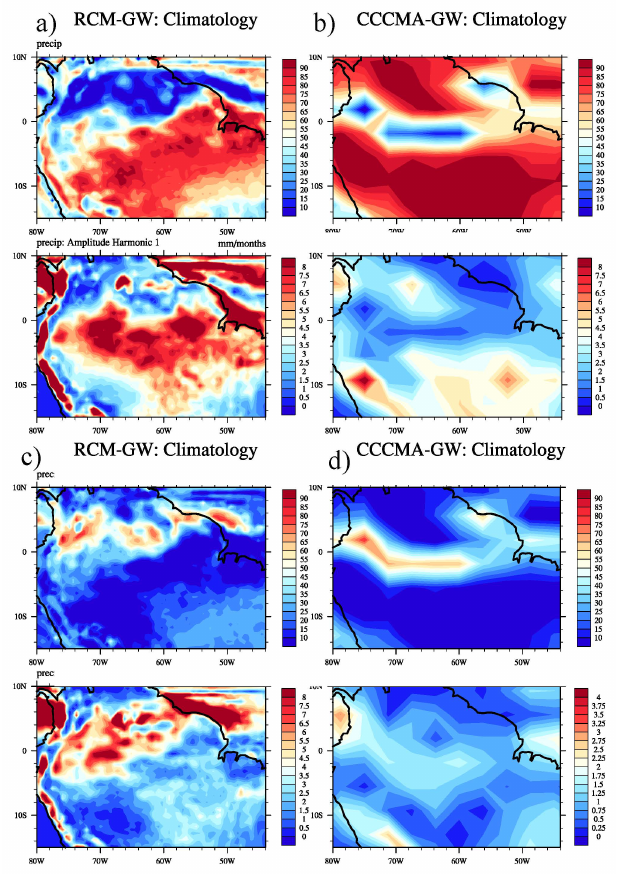
Figure 6. Same as Figure 5 but for precipitation. Lower panels of ( a , b ) show the first harmonic amplitude. ( c , d ) are the same as ( a , b ) but for the second